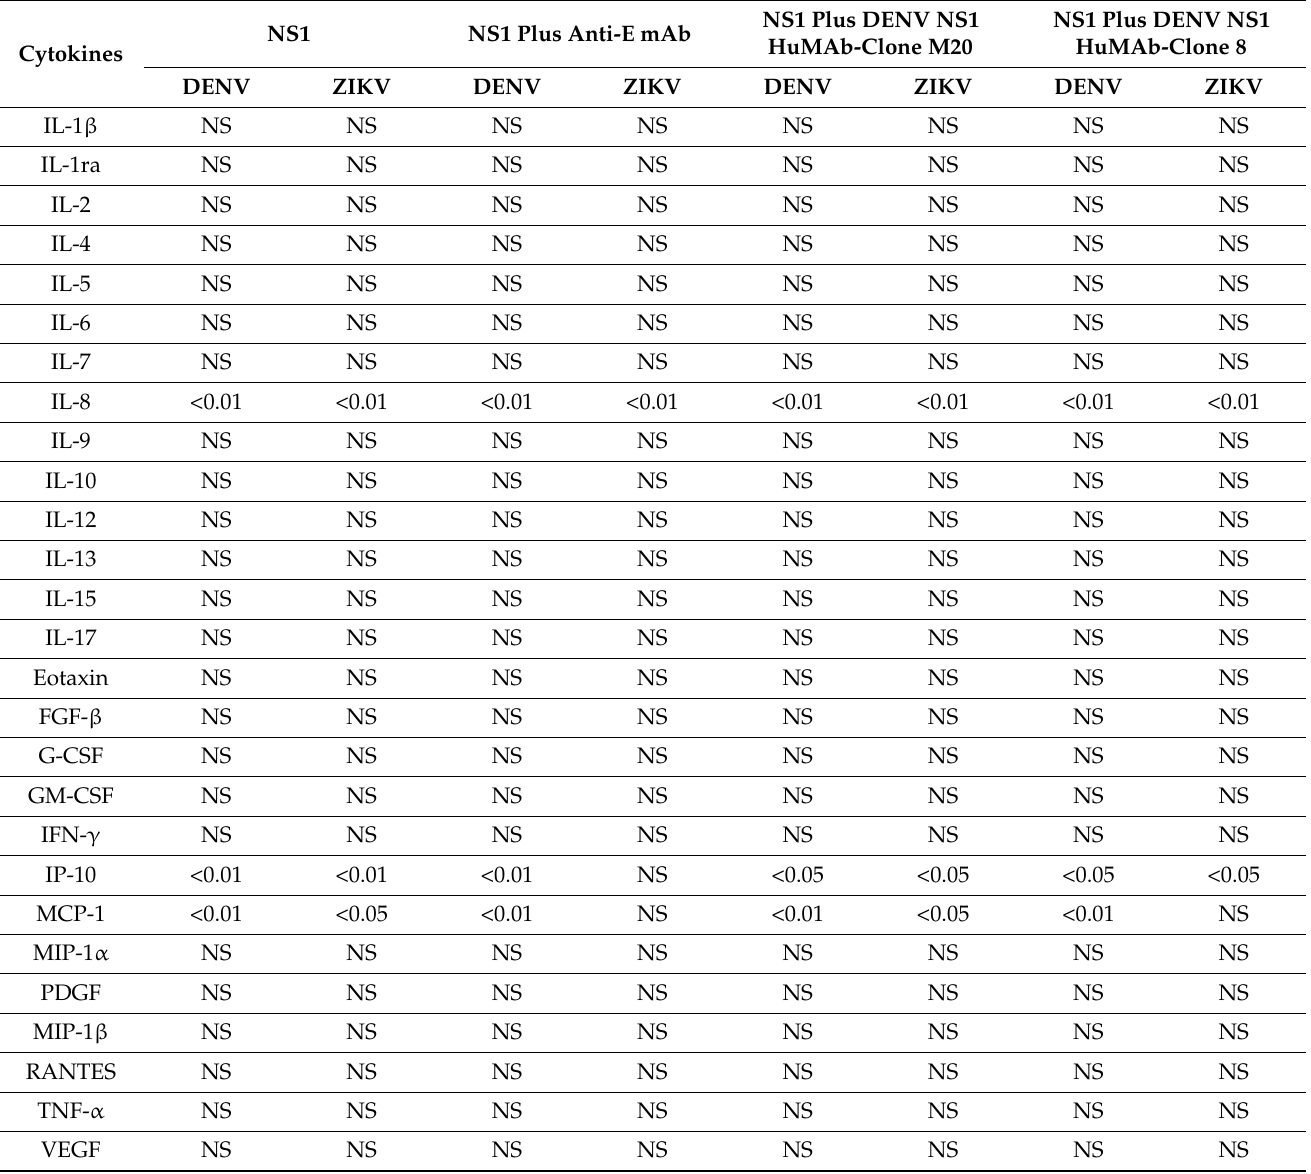
Table 3. Statistical analysis of effect of DENV NS1 HuMAbs to both DENV NS1 and ZIKV NS1- mediated inflammatory cytokines secretion in vitro compared to untreated